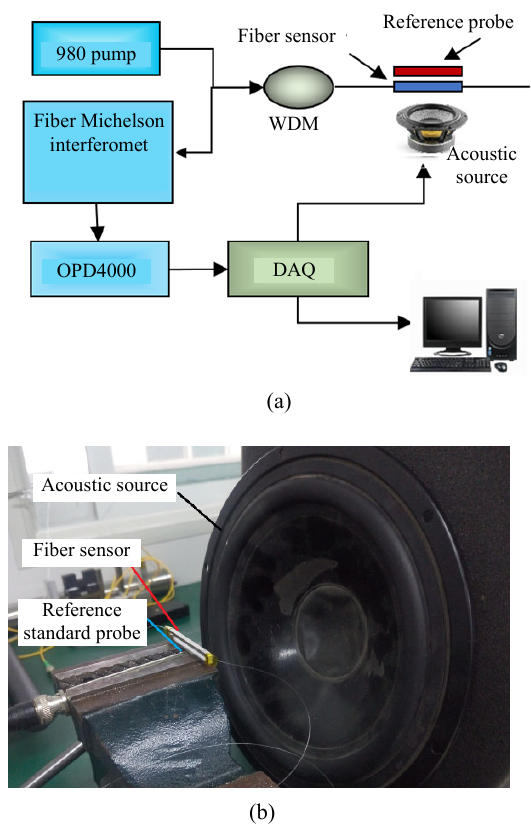
Fig. 8 Test system of DFB fiber laser acoustic sensor: (a) structure diagram and (b) picture.